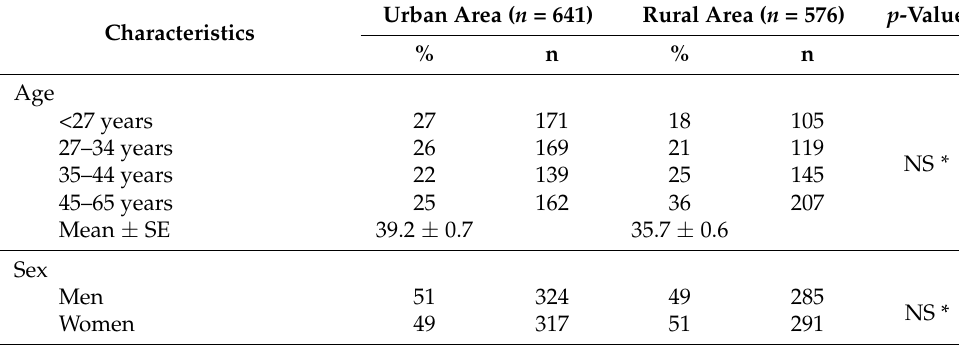
Table 1. Socio-economic status and characteristics of the participants.